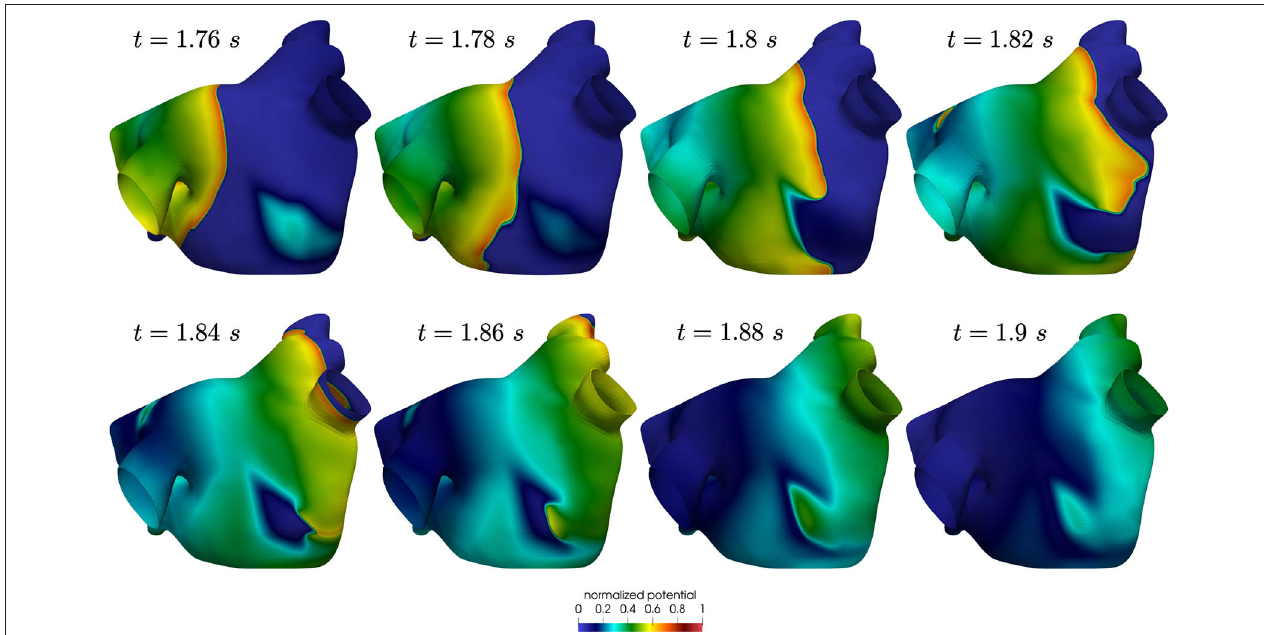
FIGURE 11 | Non sustained localized reentry in paroxysmal